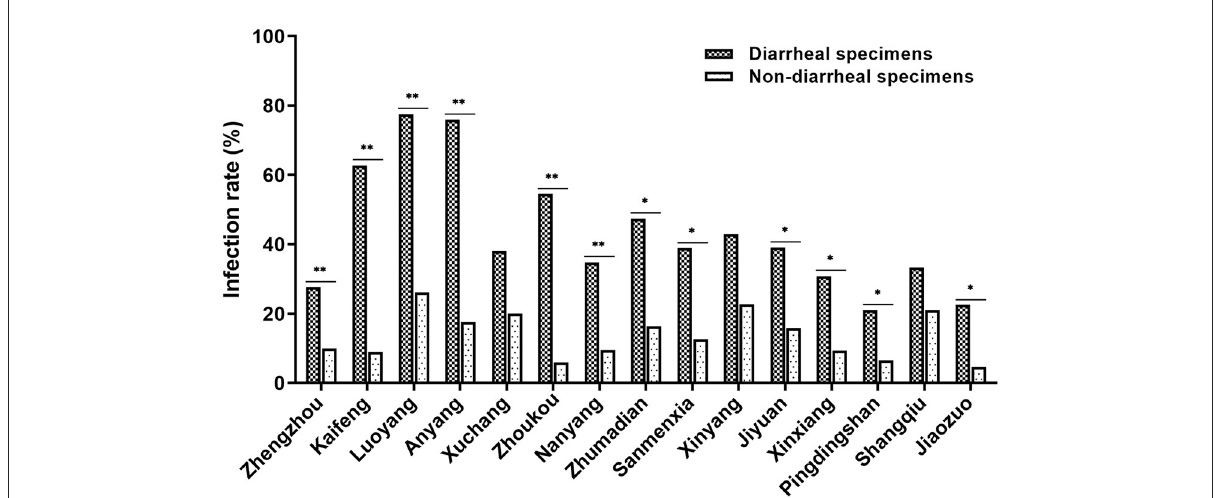
FIGURE2 CEV/OEV infection rates in diarrheal specimens and non-diarrheal specimens from different regions in Henan Province. The CEV/OEV infection rates in diarrheal specimens and non-diarrheal specimens were detected and comparatively analyzed. Dark histogram ( ) represents the CEV/OEV infection rates in diarrheal specimens, while the light bar chart ( ) represents the CEV/OEV infection rates in non-diarrheal specimens. *Indicates the significant difference between the rates ( p < 0.05), while **indicates highly significant difference ( p < 0.01).